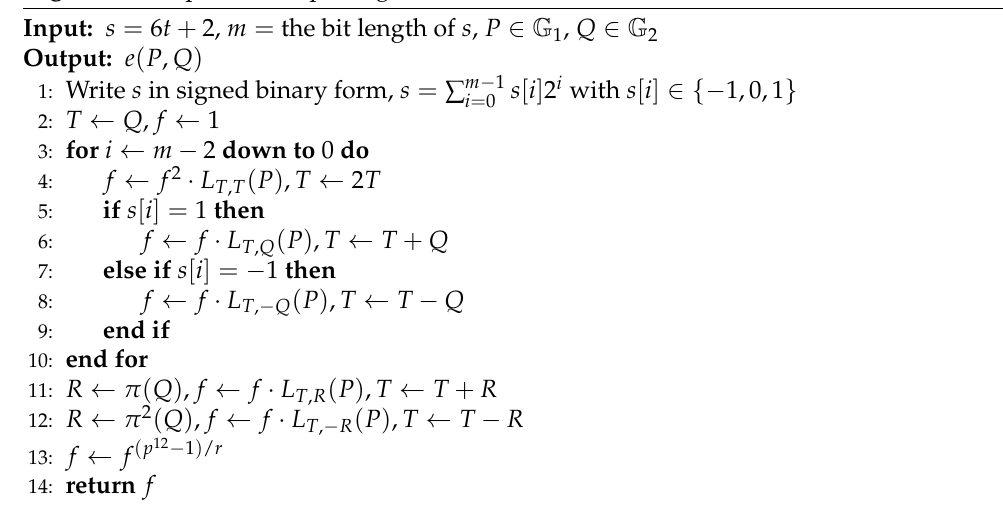
Algorithm 1 Optimal Ate pairing on the BN